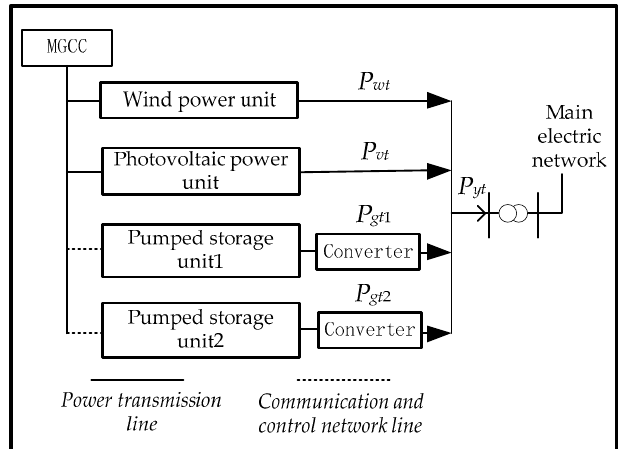
Figure 1. The structure of microgrid.